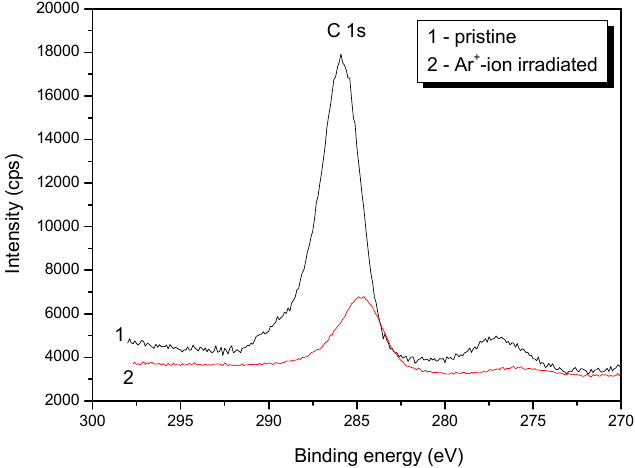
Figure 9. XPS spectra of the internal C 1 s-electrons of the investigated specimen before (1) and after (2) cleaning its surface with Ar + ions.